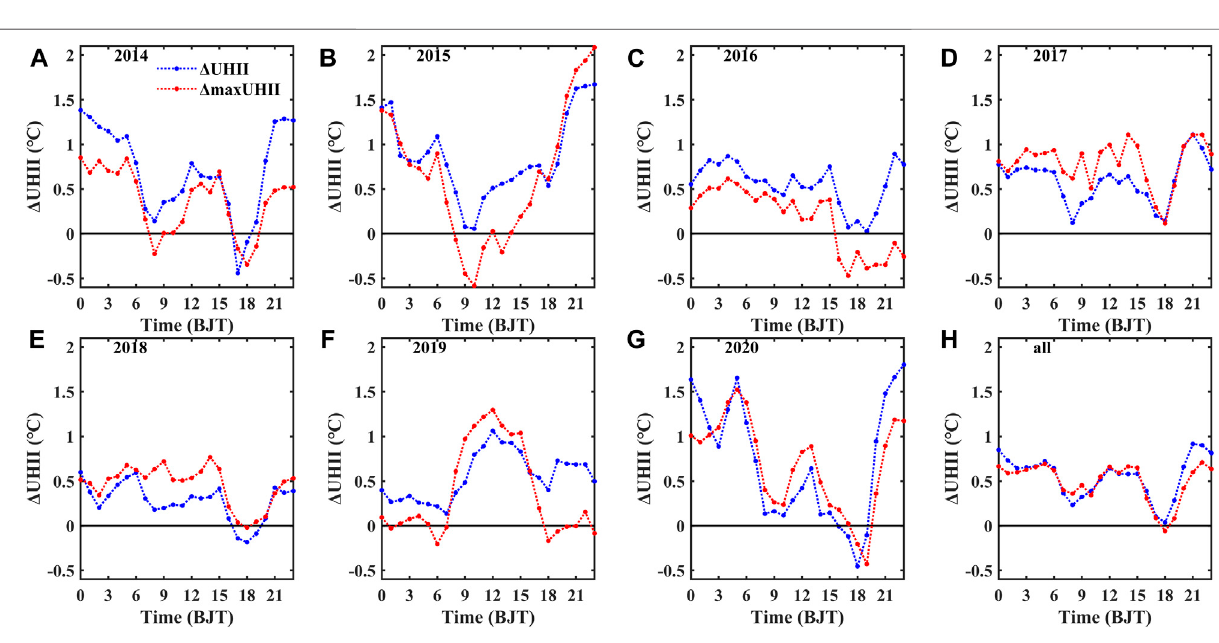
Frontiers in Earth Science |